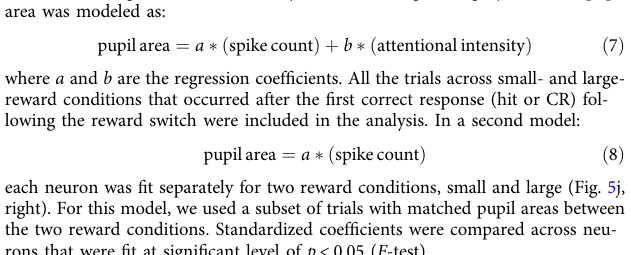
individual trial were used for linear regression analysis for pupil area versus spike count and average attentional intensity ( “ low ” and “ high ” ) (Fig. 5j, left). The